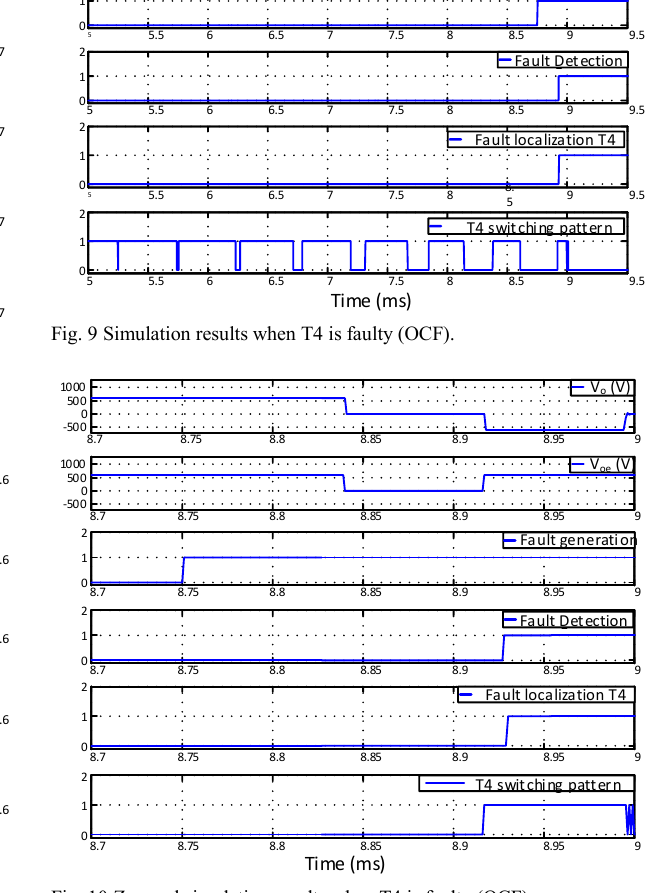
Fig. 10 Zoomed simulation results when T4 is faulty